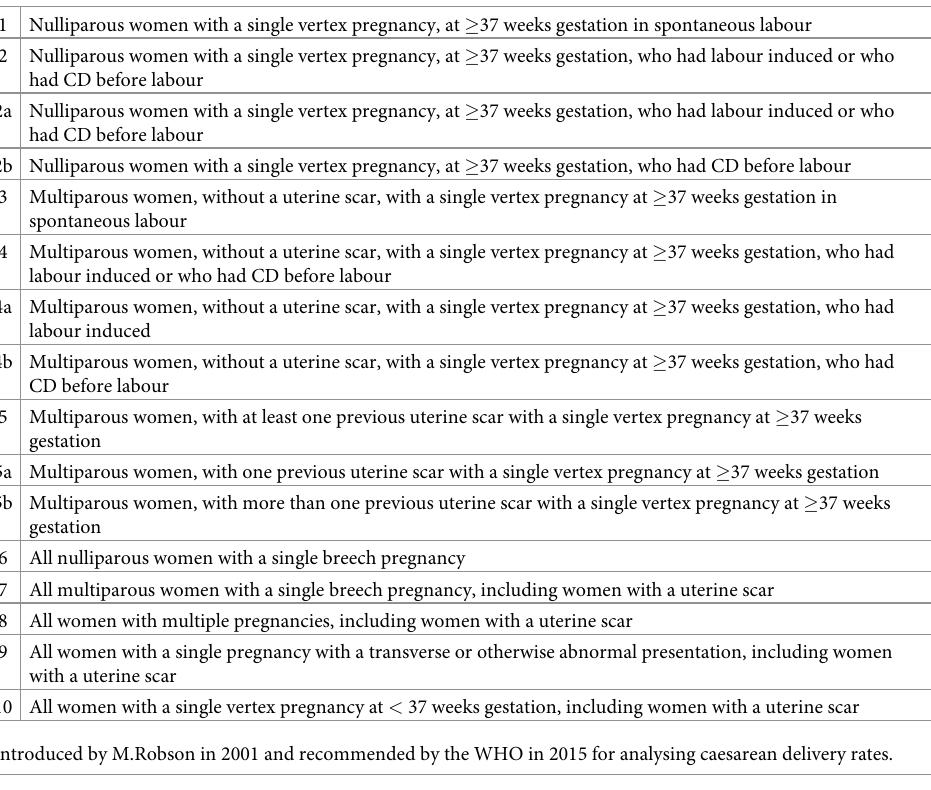
Table 1. The ten group classification